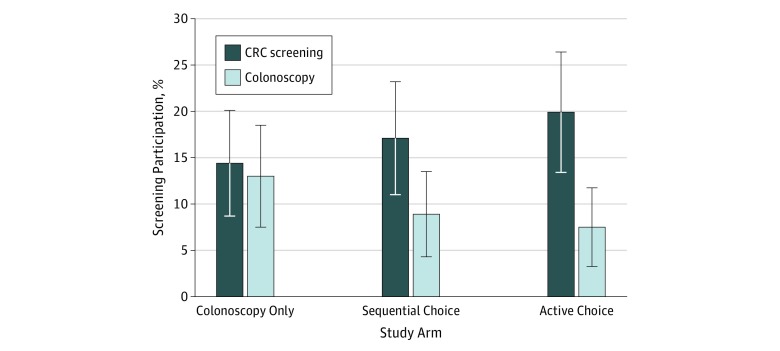
CRC Screening Completion at 4 Months by Study ArmError bars are 95% CI. CRC indicates colorectal cancer.